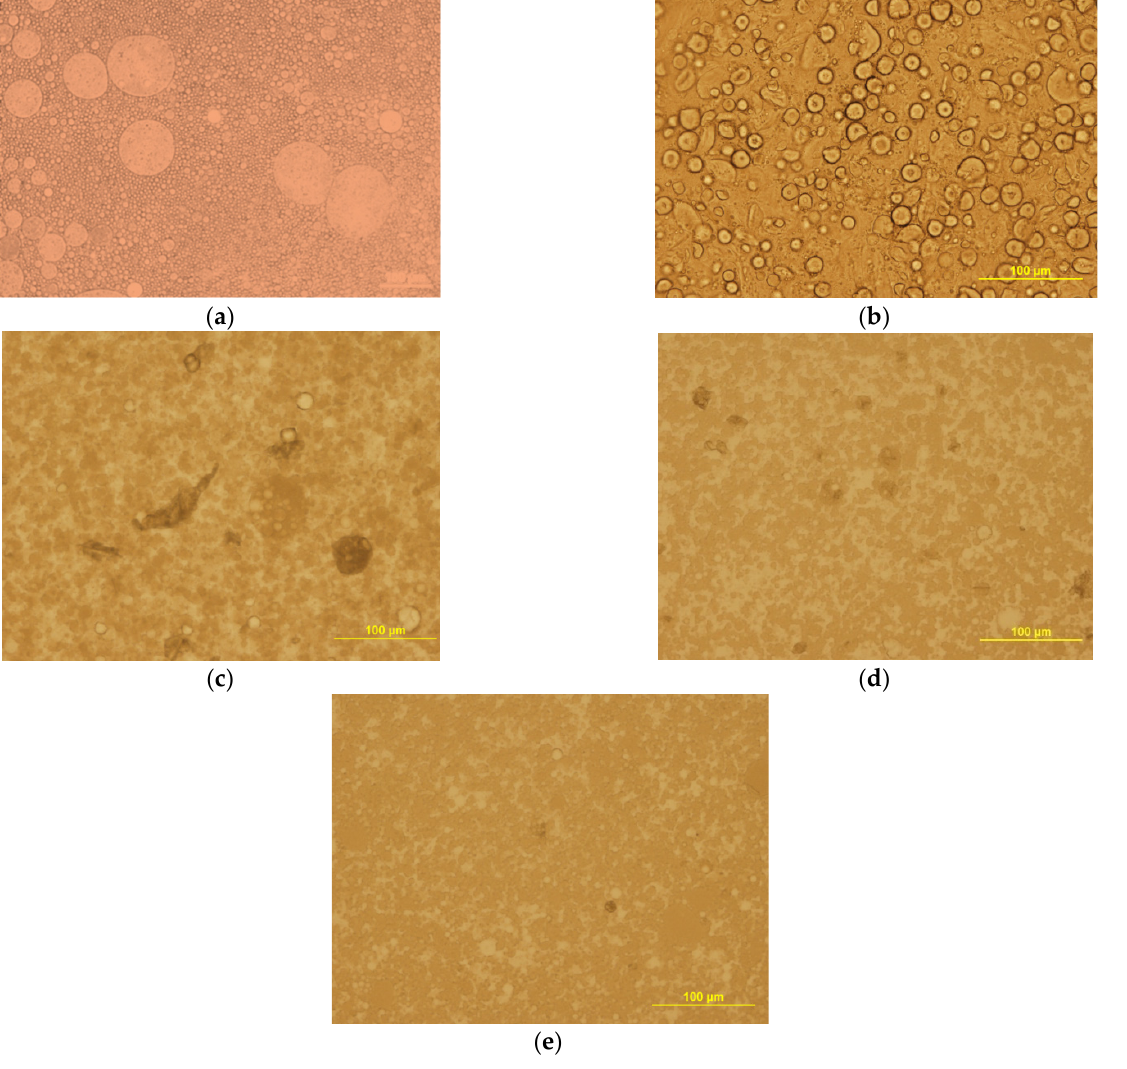
Figure 2. Micrographs of the commercial cream and mixtures of the commercial cream with the double emulsion W 1 /O/W 2 of concentration 80/20 with an internal phase ratio W 1 /O of 30/70: ( a ) double emulsion; ( b ) commercial cream; ( c ) commercial cream with 1/4 emulsion; ( d ) commercial cream with 1/3 emulsion and ( e ) commercial cream with 1/2 emulsion.